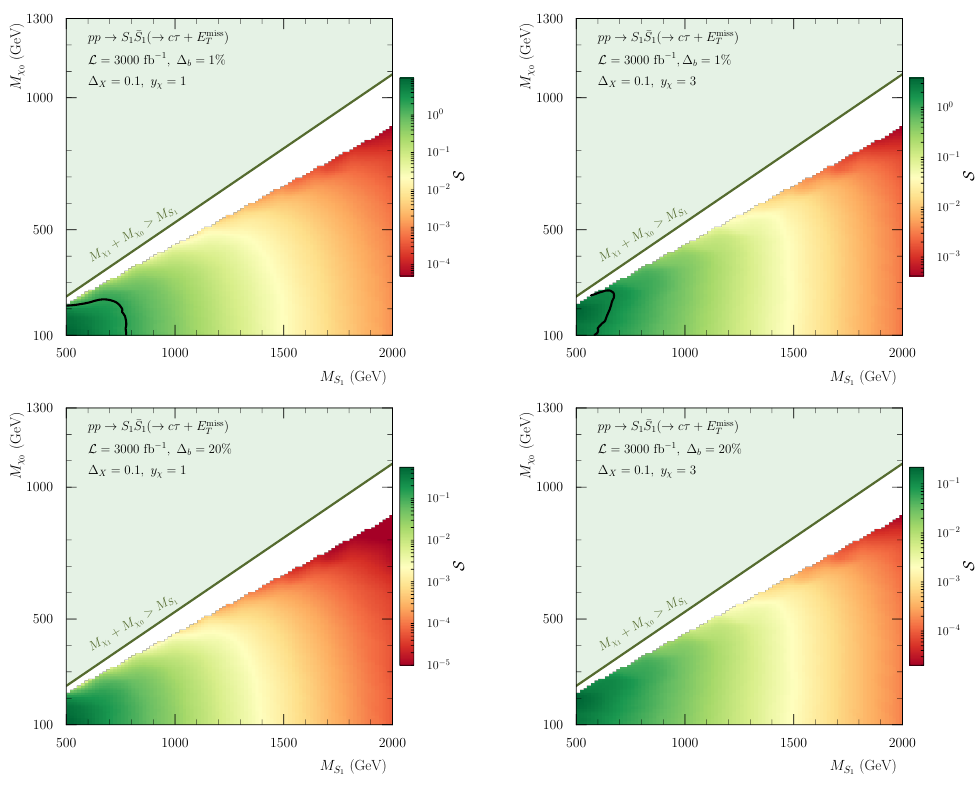
Figure 26 . Exclusion contours in the ( M S , M χ ) mass plane for y χ = 1 (left) and 3 (right) in the 1 0 proposed search for leptoquark + dark matter in 3000 fb − 1 of LHC collisions at 13 TeV. We assume a 1% (top) and 20% (bottom) uncertainty on the background. The solid black lines correspond to a 95% confidence exclusion contour, and the dark green line defines the kinematical boundary above which the dark S 1 decay is forbidden. All results are shown for ∆ X = 0 . 1